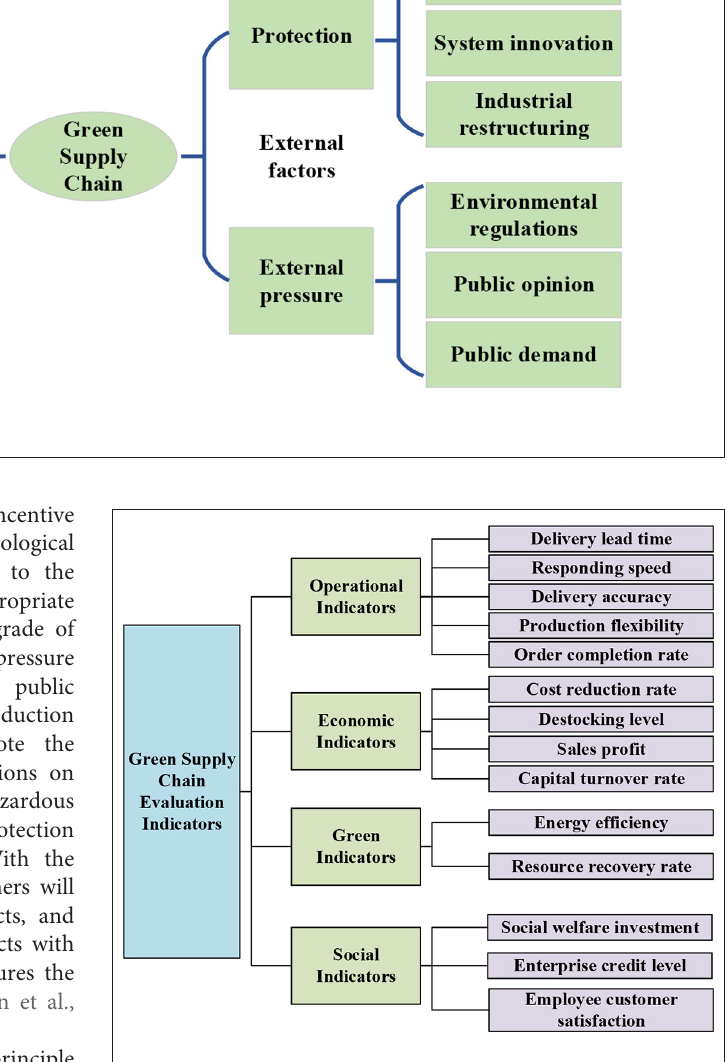
FIGURE 2 | The evaluation indicator system of the green supply